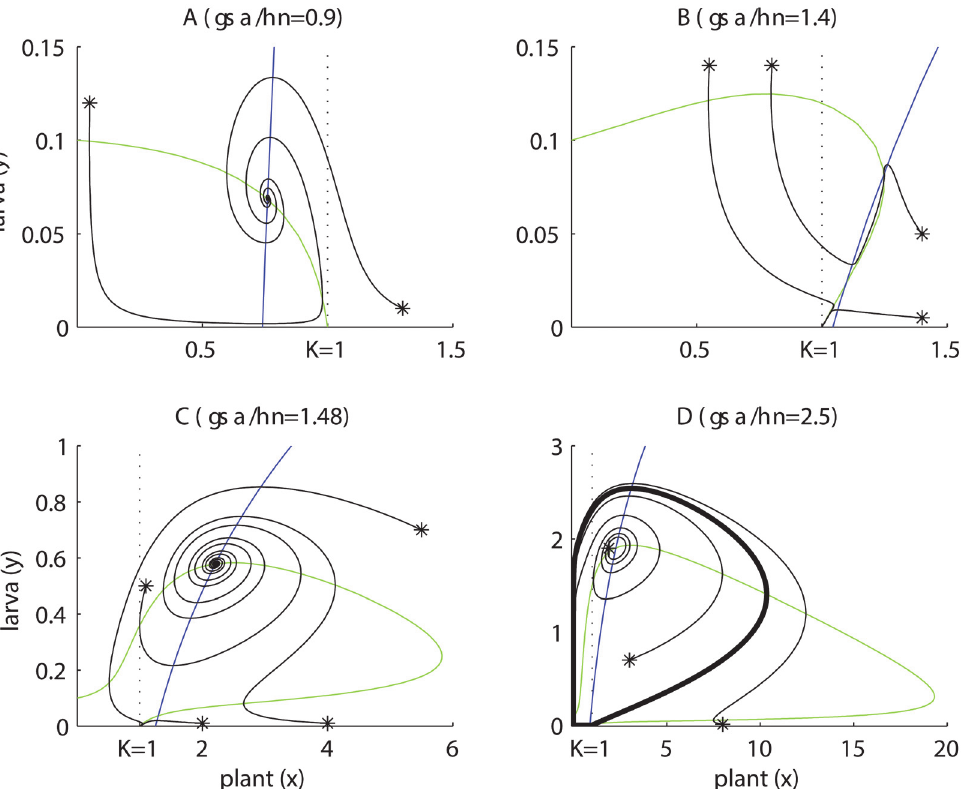
Fig 5. Dynamics of the simplified version of the PLA model. Plant isoclines in green and larva isoclines in blue. Several trajectories are shown (starting with * ). The dotted line at x = 1 is the plant ’ s carrying capacity. When γσα / ην < 1 the plant ’ s isocline always decreases, when γσα / ην > 1, it bulges above the carrying capacity and displays a hump. (A) Damped oscillations leading to globally stable coexistence dominated by antagonism (victim – exploiter). (B) The isoclines intersect as a locally stable mutualistic equilibrium and as a saddle point. Insects can coexist with the plant or go extinct depending on the initial conditions. (C) This is similar to case (B), however, a stable mutualism occurs only after damped oscillations or the insect go extinct, depending on the initial conditions. (D) Here the system develops oscillations approaching a limit cycle (thick loop), which creates a periodic alternation between mutualism and antagonism. Common parameters in all panels are β = 10, η = 0.1, μ = 1, ϕ = 0. For the other parameters; in (A): σ = 3, ε = 0.7, α = 3, γ = 0.02, ν = 2; in (B): σ = 2.1, ε = 0.21, α = 2, γ = 0.05, ν = 1.5; in (C): σ = 3.7, ε = 0.2, α = 3, γ = 0.02, ν = 1.5; in (D): σ = 5, ε = 0.3, α = 5, γ = 0.02, ν =